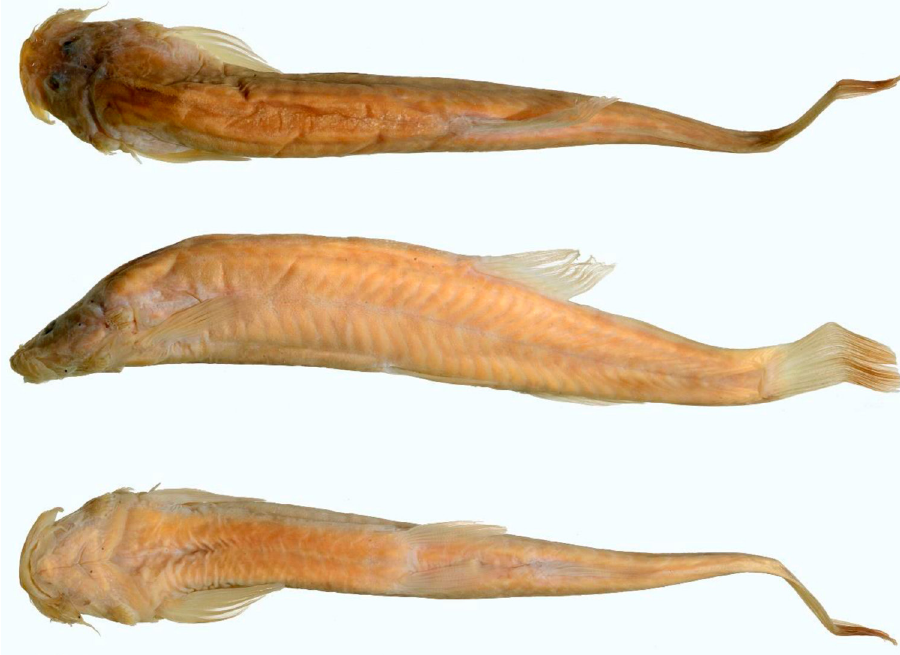
FIGURE 24 | Scleronema operculatum , holotype (FMNH 58080; 65.9 mm SL), Brazil, Rio Grande do Sul, Cacequi, rio Cacequi, tributary to rio Santa Maria, rio Ibicuí basin, lower rio Uruguay. Photograph taken by Sandra